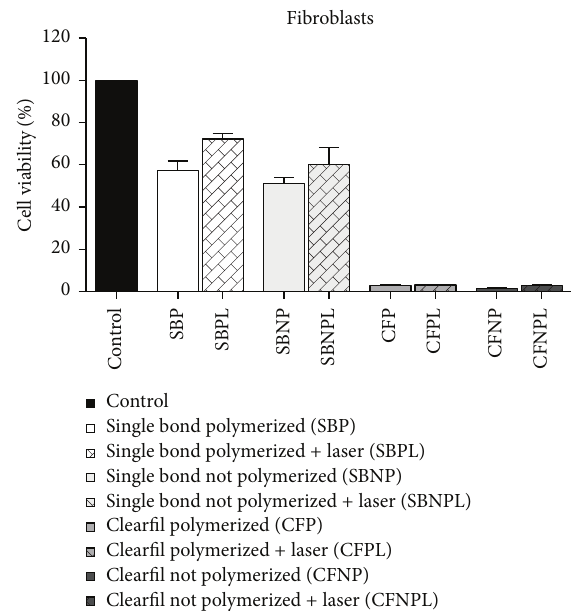
Figure 5: Graphic representation of the cell viabilities of fibroblasts in response to the substances leached from the dental adhesives: Adper Single Bond 2 and Clearfil SE Bond, whether or not polymer- ized and followed by LPT or not. There are no differences between irradiated and nonirradiated cells submitted to the same adhesive